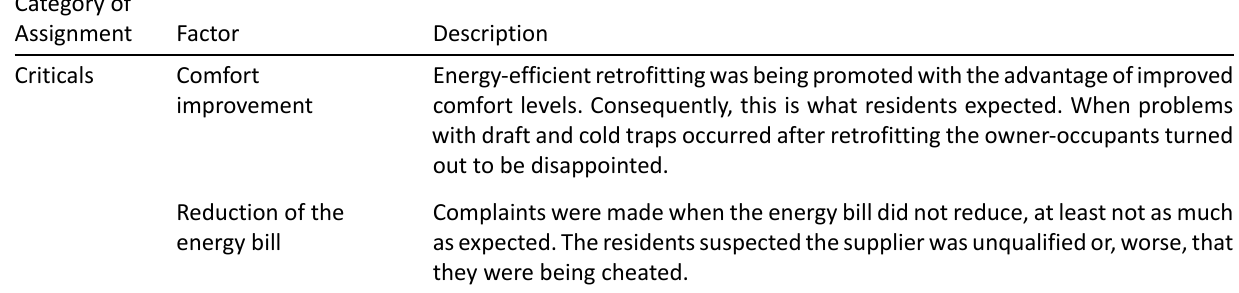
Table 2. (Cont.) Dissatisfiers, satisfiers, criticals, and neutrals in the perception of owner‐occupants involved in #ENEXAP. Category of